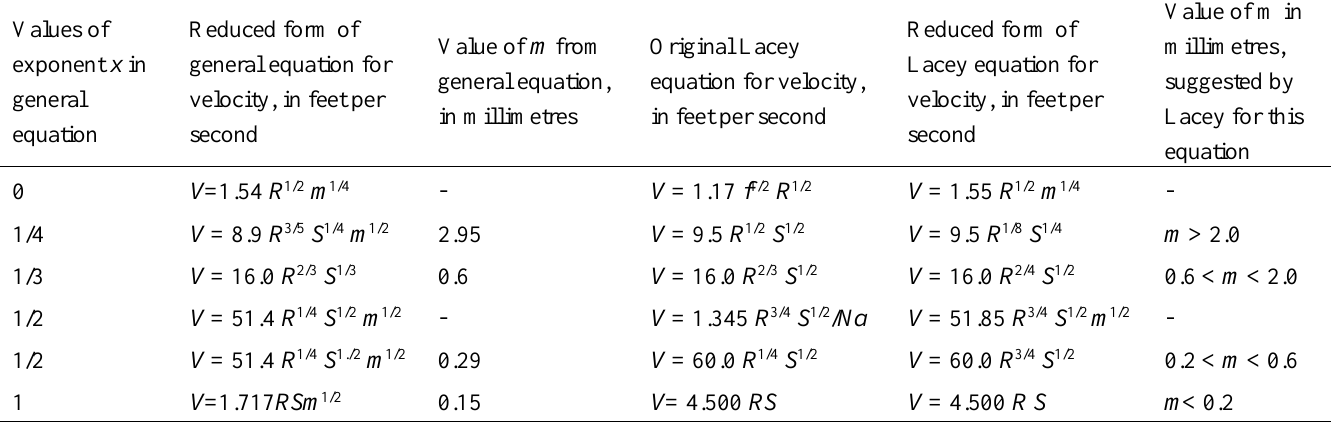
Value of m from Original Lacey